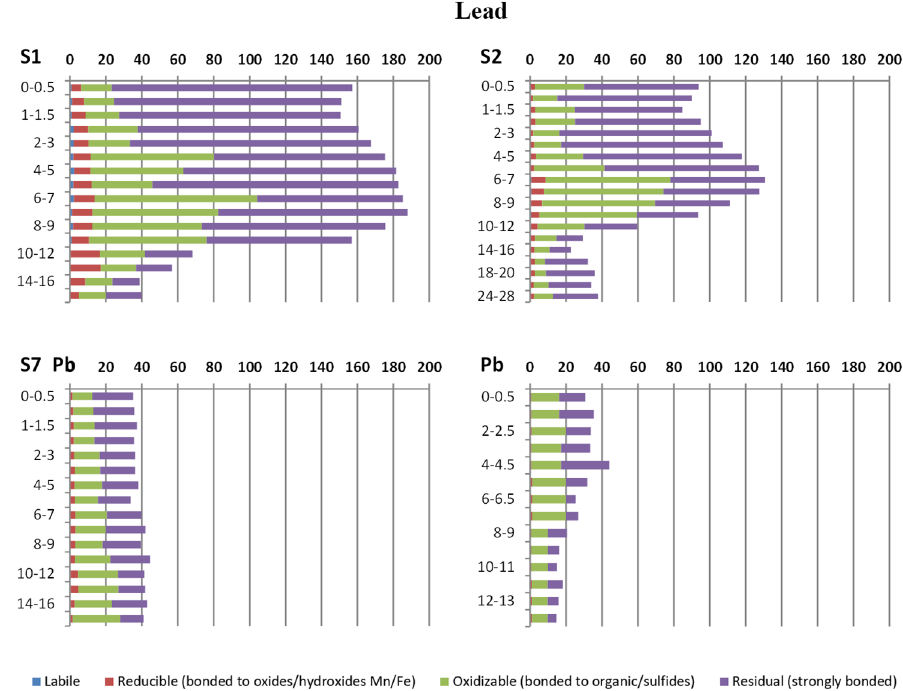
Figure 8. Chemical fractionation of Cd in sediments from the S1, S2, S7, and S11 stations. Horizontal axis: concentration (mg/kg). Vertical axis: core depth (cm).